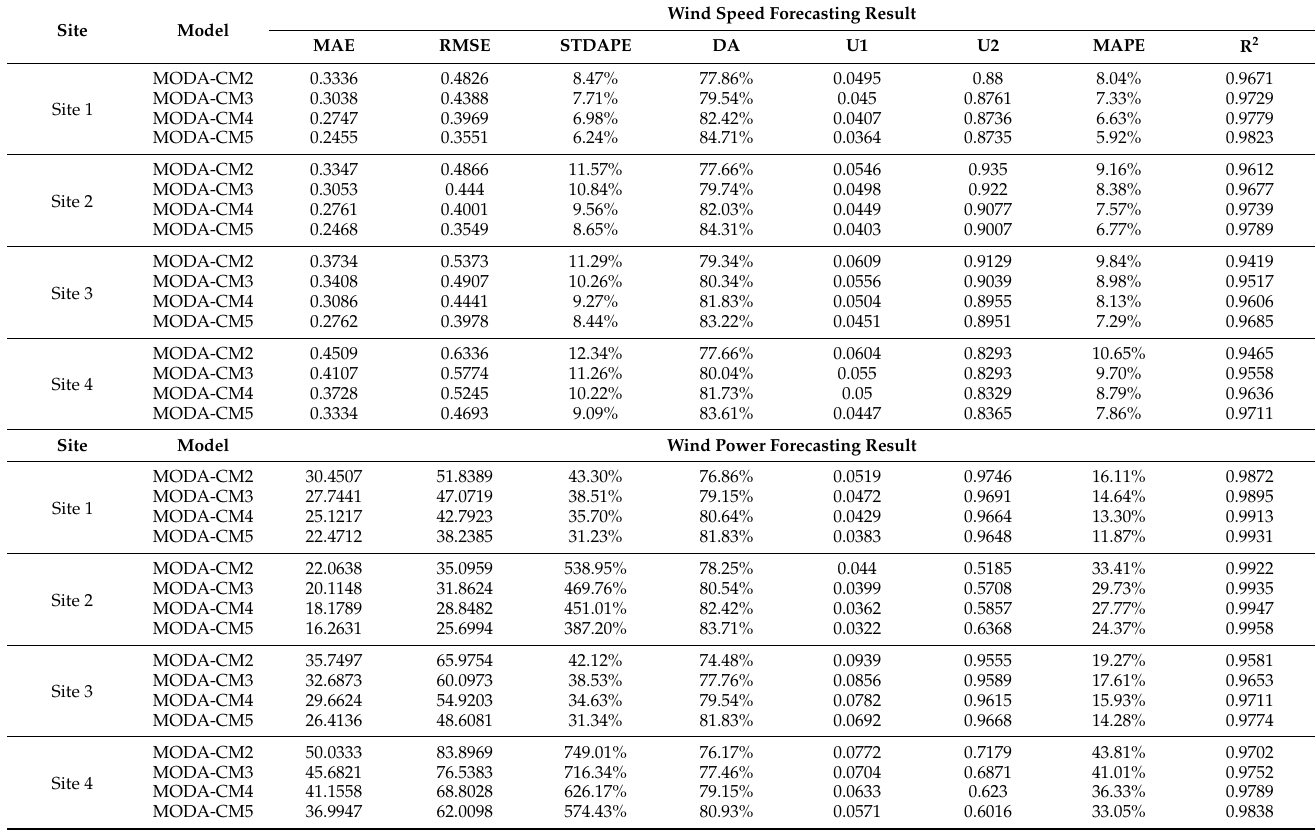
Table 7. The forecasting results of each combined models for different sites in the fourth